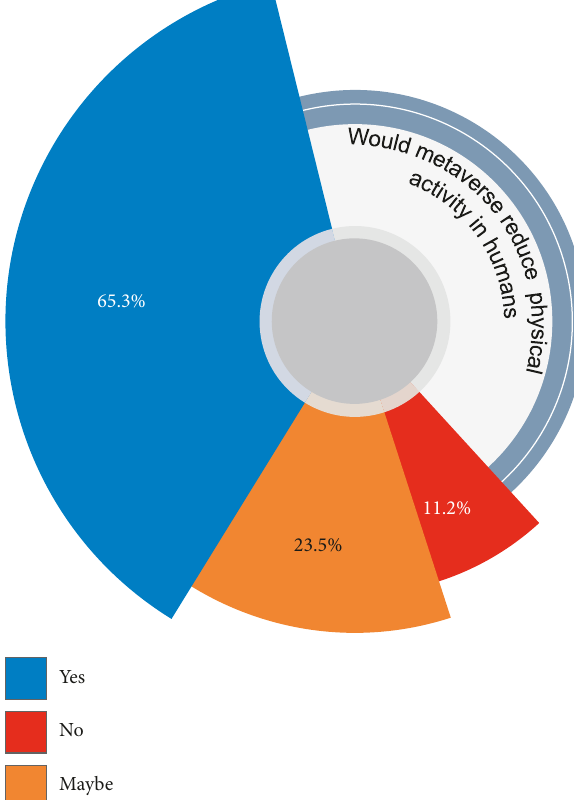
Figure 11: Summarization of the responses when people were asked if a metaverse would create a communication gap and reduce human interactions.